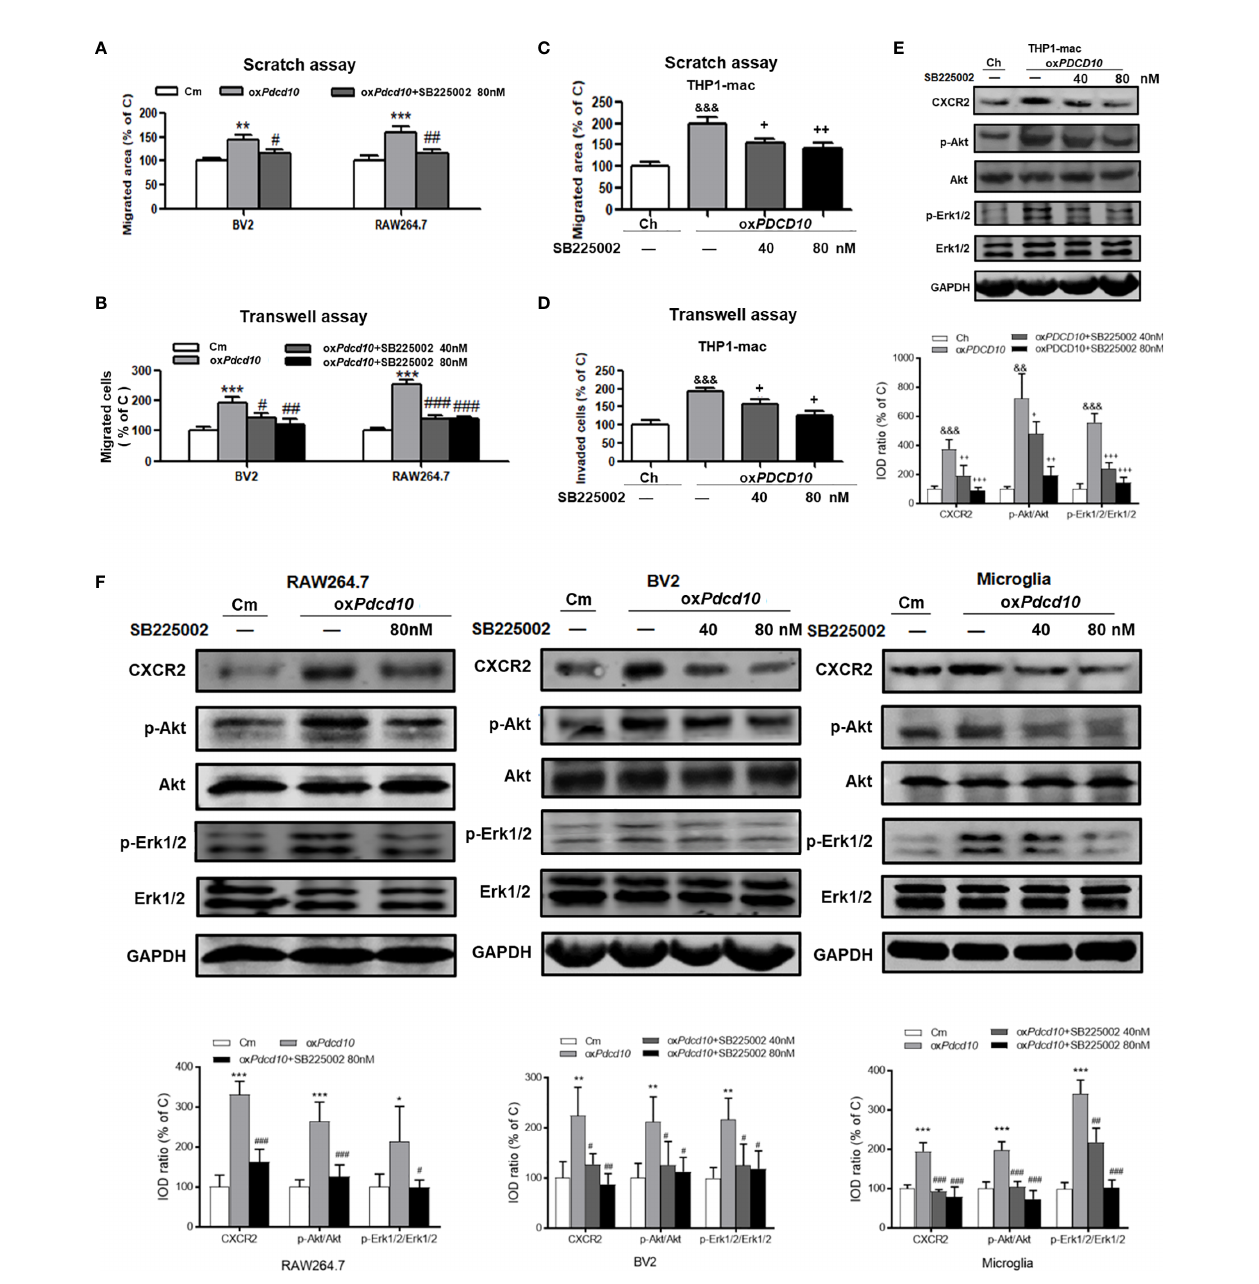
FIGURE 6 | SB225002 treatment suppressed CXCR2 activation and cell migration in microglia and macrophages induced by PDCD10-upregulated GBM cells. Cell migration was detected in murine BV2 and RAW264.7 cells (A, B) and in human THP1-mac cells (C, D) . For scratch assay (A, C) , cells were treated with 40 nM or 80 nM SB225002 for 48 hours. To perform transwell assay (B, D) , 40 nM or 80 nM SB225002 was used for cell treatment for 24 hours. CXCR2 and downstream signaling pathways in human THP1-mac (E) murine primary microglia, BV2 and RAW264.7 cells (F) were detected by Western blot. *p < 0.05, **p < 0.01 and ***p < 0.001, compared with Cm; SB225002 treatment suppressed CXCR2 activation and cell migration in # p < 0.05, ## p < 0.01 and ### p < 0.001, compared with oxPdcd10; && p < 0.01, &&& p < 0.001, compared with Ch; + p < 0.05, ++ p < 0.01 and +++ p < 0.001 compared with